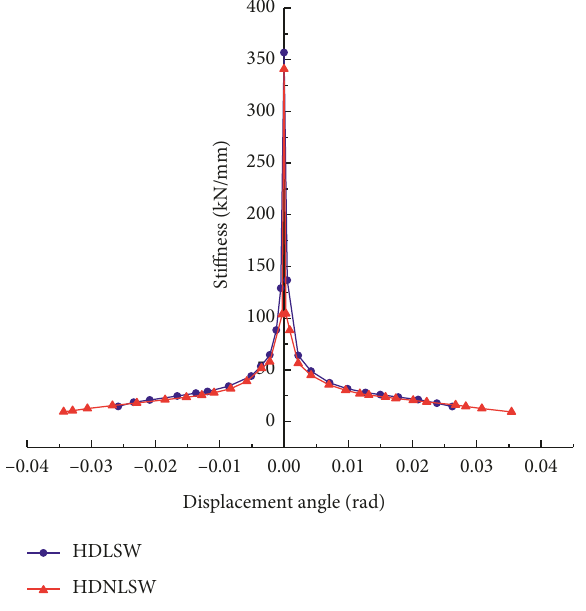
Figure 13: The contrast diagram of attenuation curves of rigidity. Table 5: Variance of the frequency and the damping ratio of undamaged and damaged specimens.